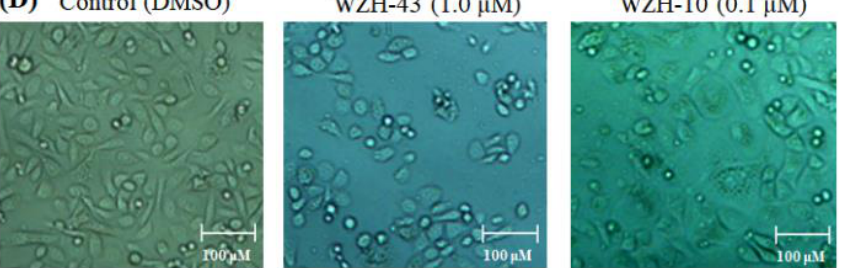
Figure 1. Effect of two prenylated chalcones on the proliferation of PC3 cells. ( A ) Chemical structure of WZH-43 and WZH-10. Cell viability of PC3 cells in vitro after the treatment with WZH-43 ( B ) and WZH-10 ( C ). ( D ) morphology of PC3 cells after the exposure to the two compounds for 48 h by optical microscope. Cells (1 × 10 4 cells/mL) were treated with compounds at different concentrations for 48 h. The cell viability was calculated by MTT assay and the IC 50 values were determined. Values are expressed as mean ± SD of three independent experiments. Scale bar = 100 μM in all images. * p < 0.05, ** p < 0.01 compared with the control.